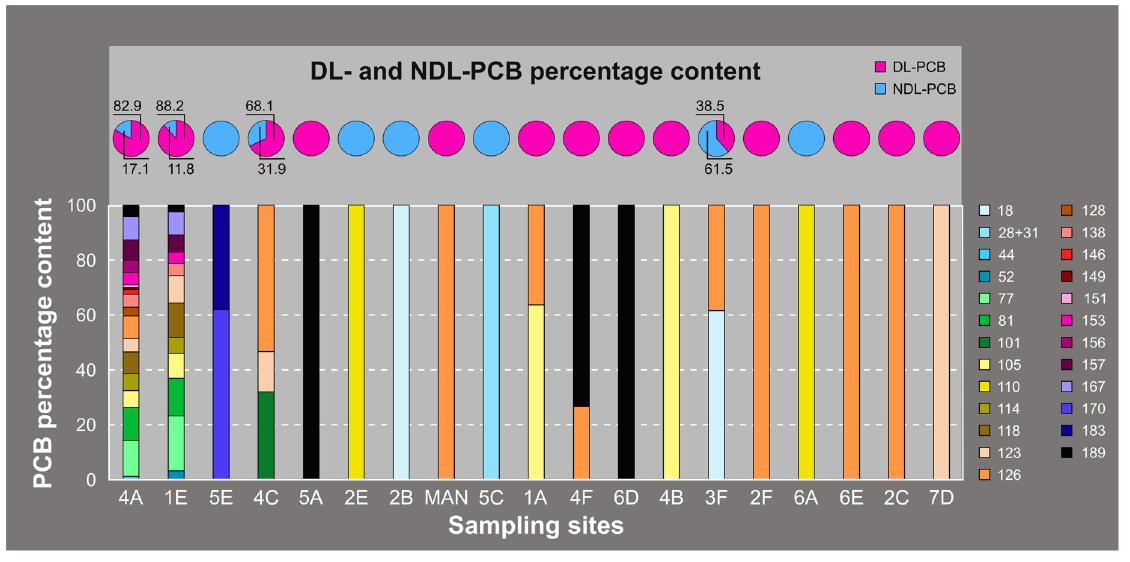
Figure 2. Percentage content of PCB congeners measured in the 19 Robinia pseudoacacia leaf samples collected at the 32 sampling sites shown in Figure 1 with PCB content > LOD. The samples are sorted along the abscissa in descending order according to the total content of all 32 PCBs. The upper pie graphs show the percentage content of dioxin-like (DL) and non-dioxin-like (NDL) PCBs.